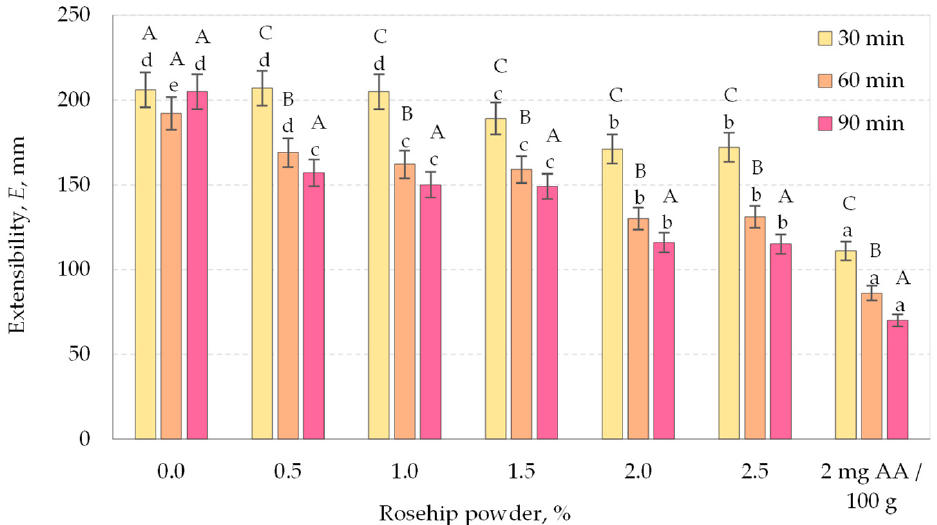
Figure 2. Extensibility ( E , mm) as a function of Rp addition. Different capital letters represent statistically different mean values ( p ≤ 0.01) of each sample for different times (30, 60, and 90 min). Different lower-case letters are responses statistically different ( p ≤ 0.01) of all samples for each time (30, 60, and 90 min). AA is ascorbic acid.